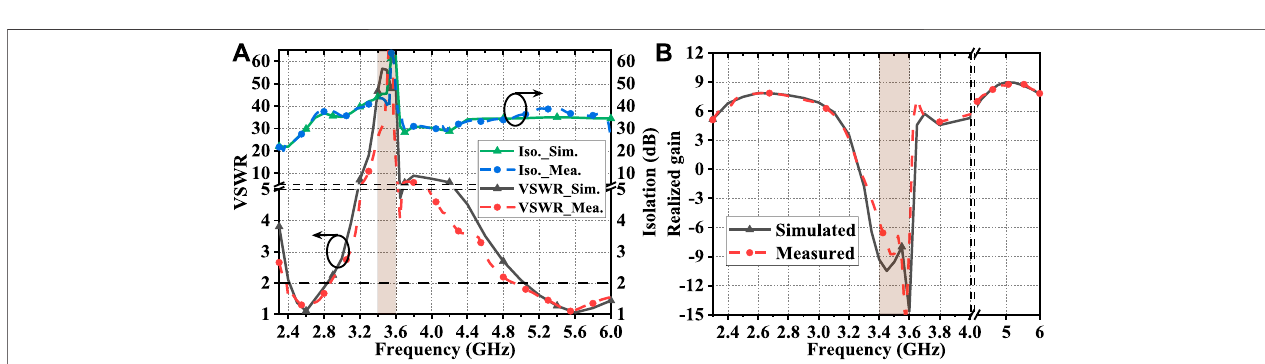
FIGURE 14 | Simulated and measured VSWRs and isolation of the proposed antenna.